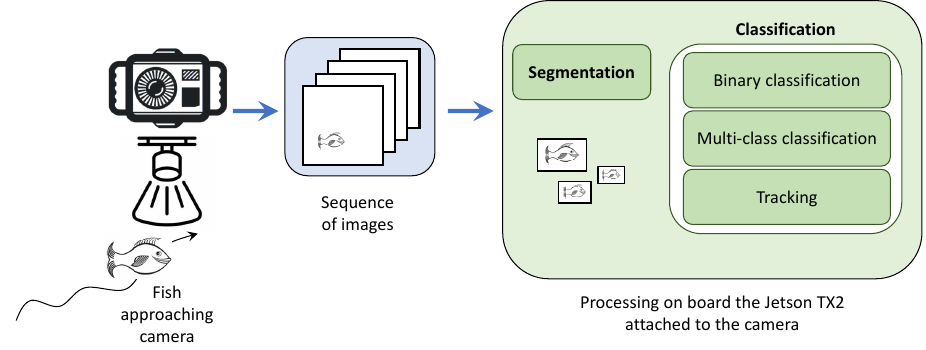
Figure 1. The optical data pipeline, including segmentation, classification, and object